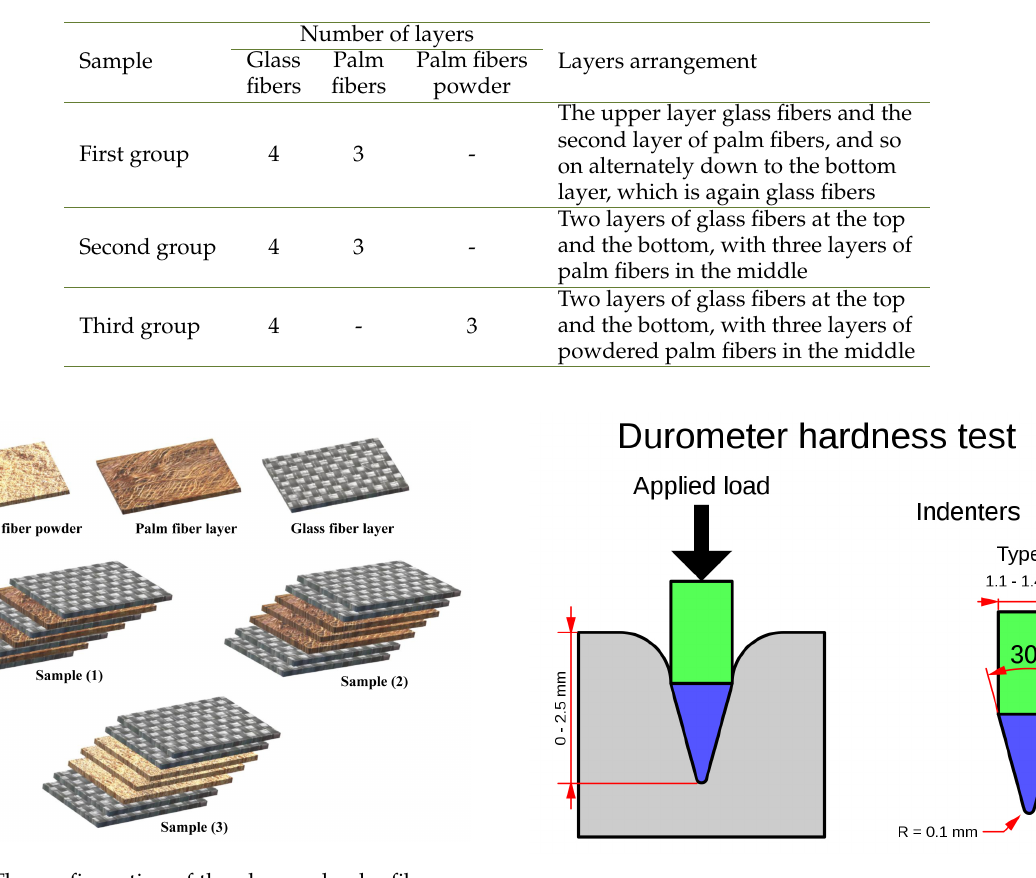
Fig. 2. The configuration of the glass and palm fibers throughout the manufactured specimens.